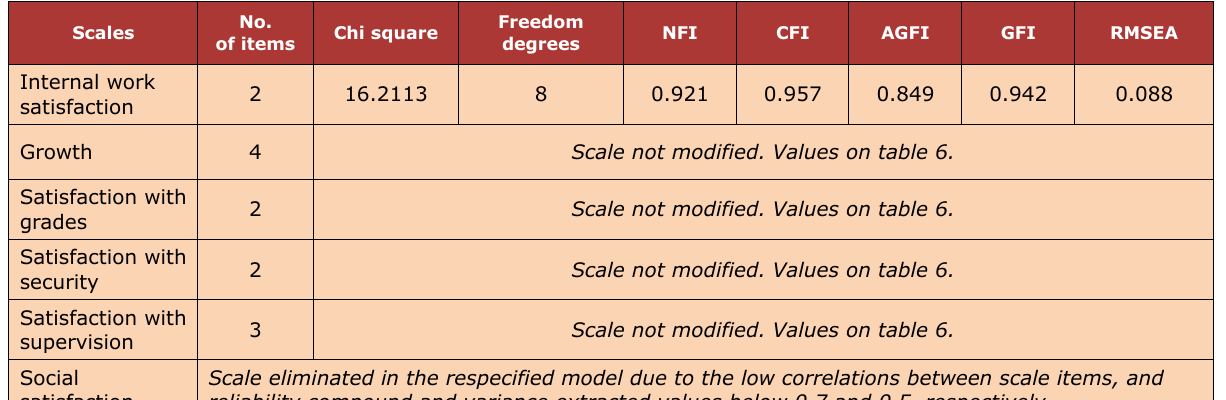
Table 7.Goodness of fit indexes of the respecified model